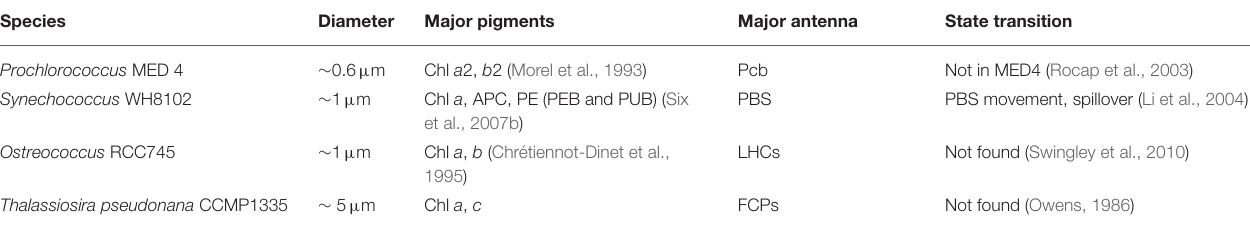
TABLE 1 | Key properties of Prochlorococcus, Synechococcus, Ostreococcus, and Thalassiosira. Species